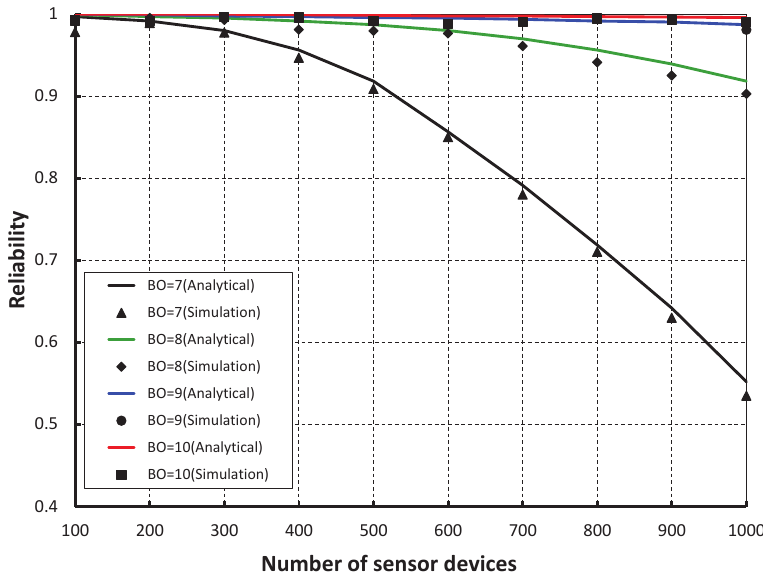
Figure 10. Validation of reliability for different beacon